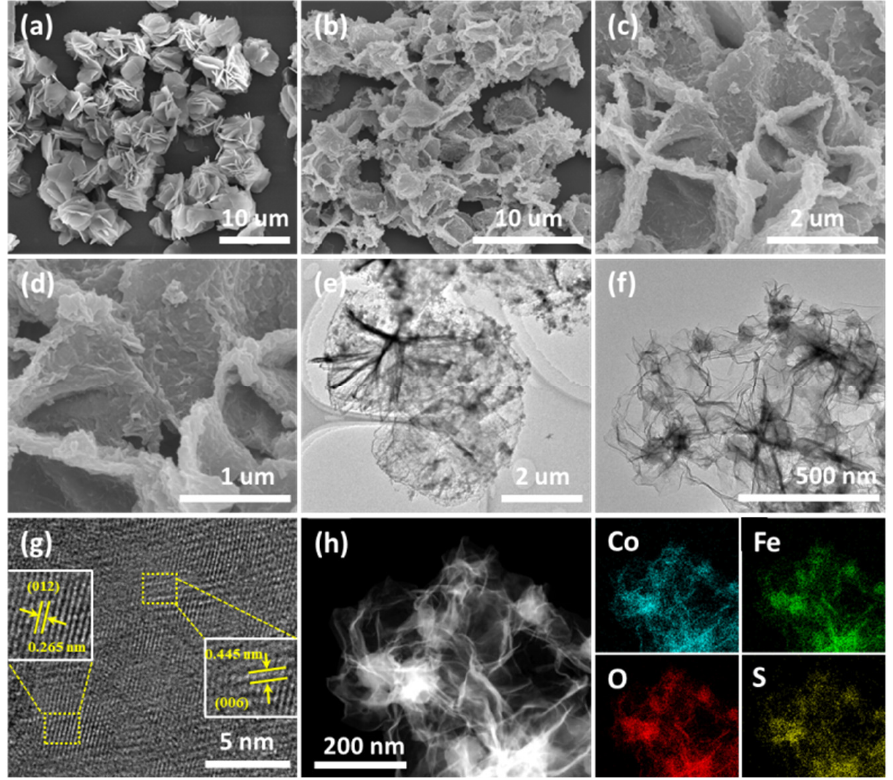
Figure 3. ( a ) FE-SEM image of ZIF-9(III), ( b – d ) FE-SEM images, ( e , f ) TEM and ( g ) HRTEM images in different magnifications of CoFe LDH, and ( h ) EDX elemental mapping images for CoFe LDH.